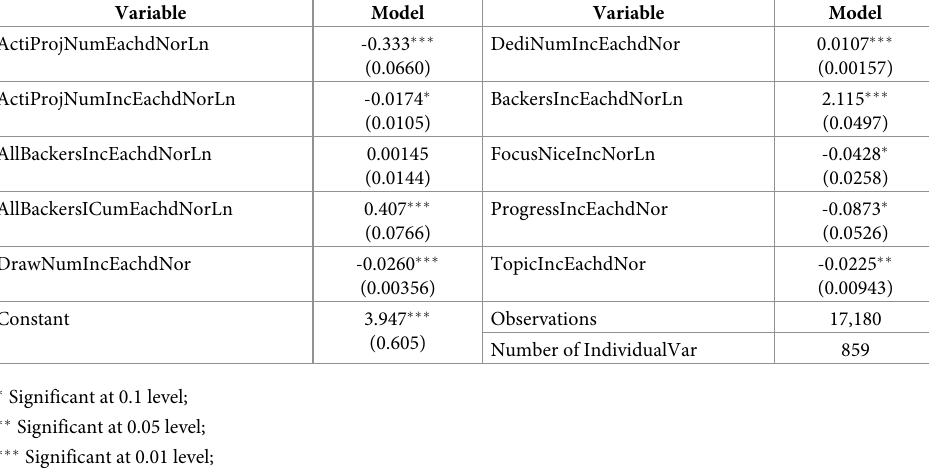
Table 7. FE model on the implicit signals of projects using PledgesIncrNorYLn as dependent variable. Variable